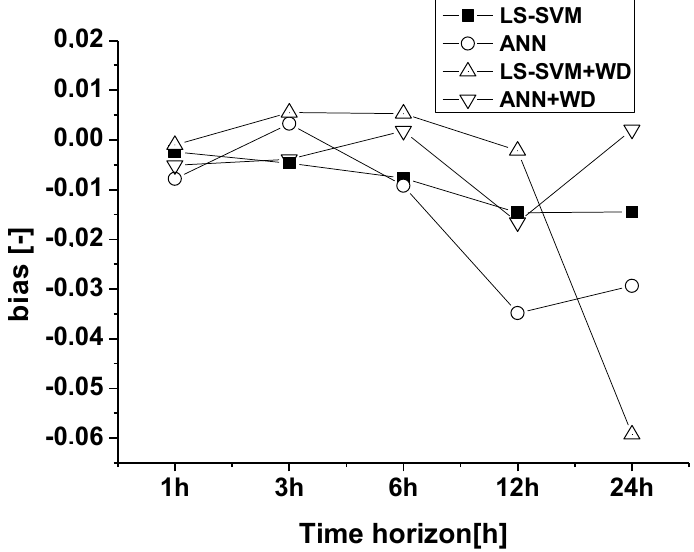
Figure 7. Bias error for input vector Type II by LS-SVM and ANN without and with